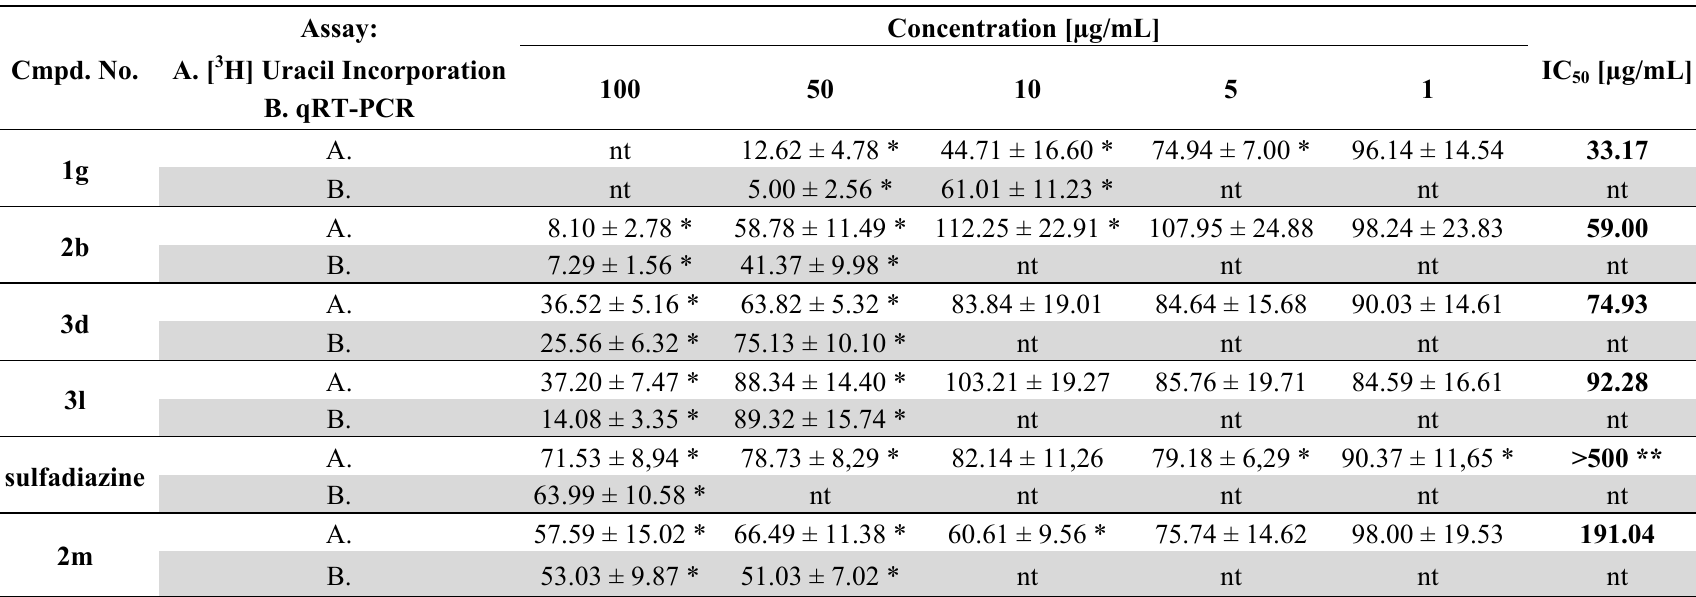
Table 1. Effect of studied compounds on the intensity of T. gondii proliferation (%) in the L929 host cells. Cmpd.